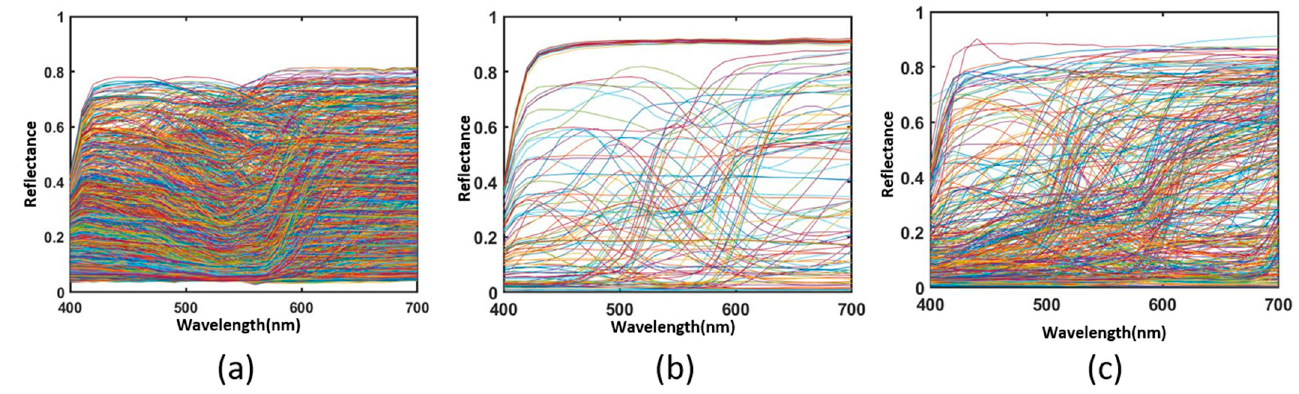
Figure 2. ( a ) Spectral sensitivity functions and ( b ) the spectral power distribution of D65.